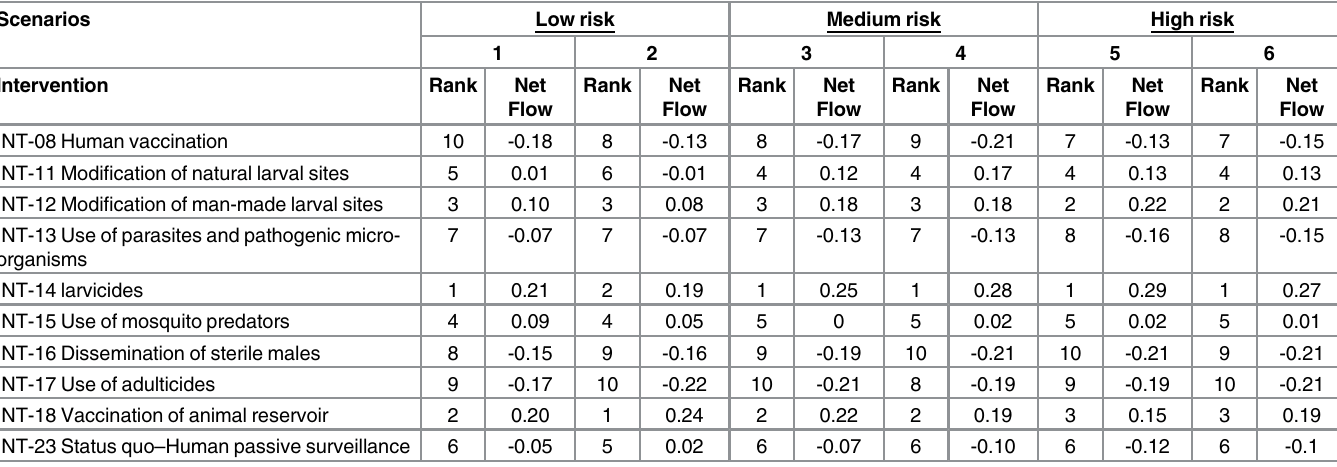
Table 5. Ranking of the regional-level management interventions.